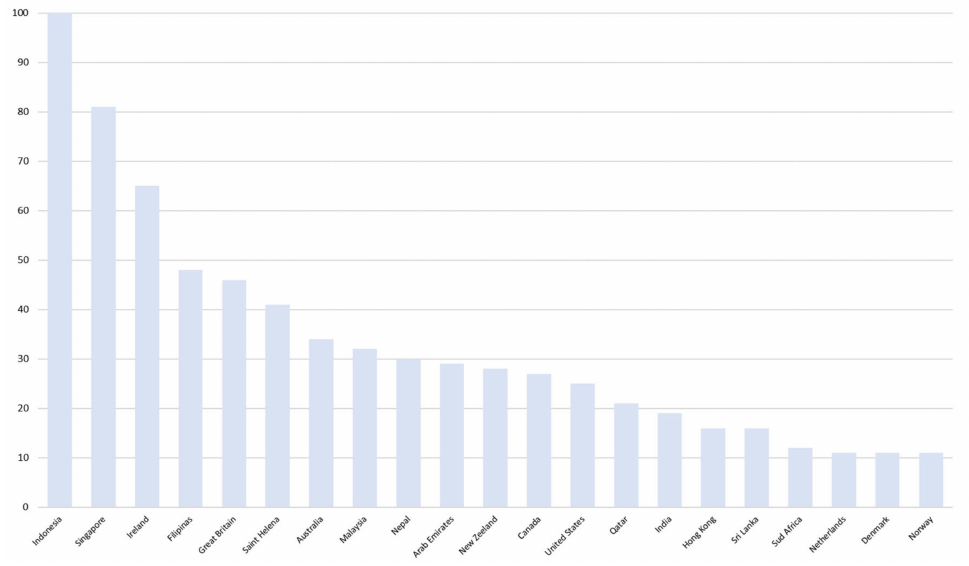
Figure 2. Interest by region in solo travel Google